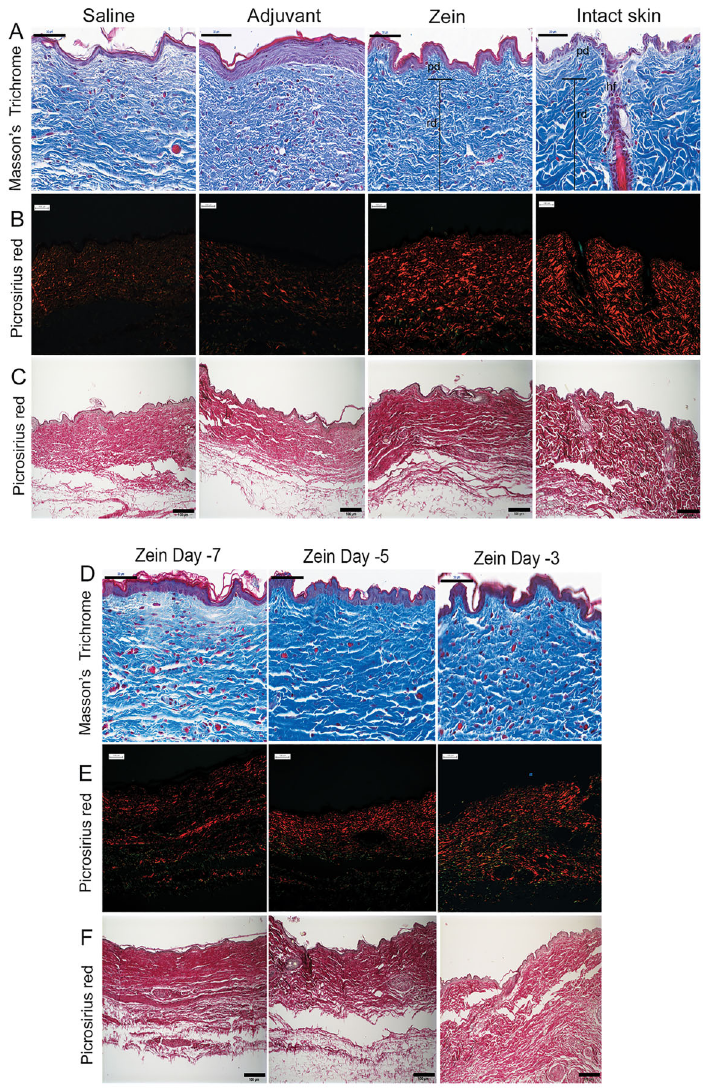
Figure 3. Subcutaneous injection of zein up to 5 days before skin injury improved the pattern of collagen arrangement. A – C , Representative sections of intact skin or wounds harvested 40 days after skin injury in mice injected with saline, adjuvant, or Zein plus adjuvant, minutes prior to injury. D – F , Representative sections of wounds harvested 40 days after skin injury in mice injected with Zein plus adjuvant 7, 5, or 3 days before skin injury. Skin sections stained with ( A and D ) Masson ’ s trichrome, ( B and E ) Picrosirius red under polarization light, or ( C and F ) Picrosirius red without polarization light. hf: hair follicle; pd: papillary dermis; rd: reticular dermis. Scale bars: 50 m m (Masson ’ s trichrome); 100 m m (Picrosirius